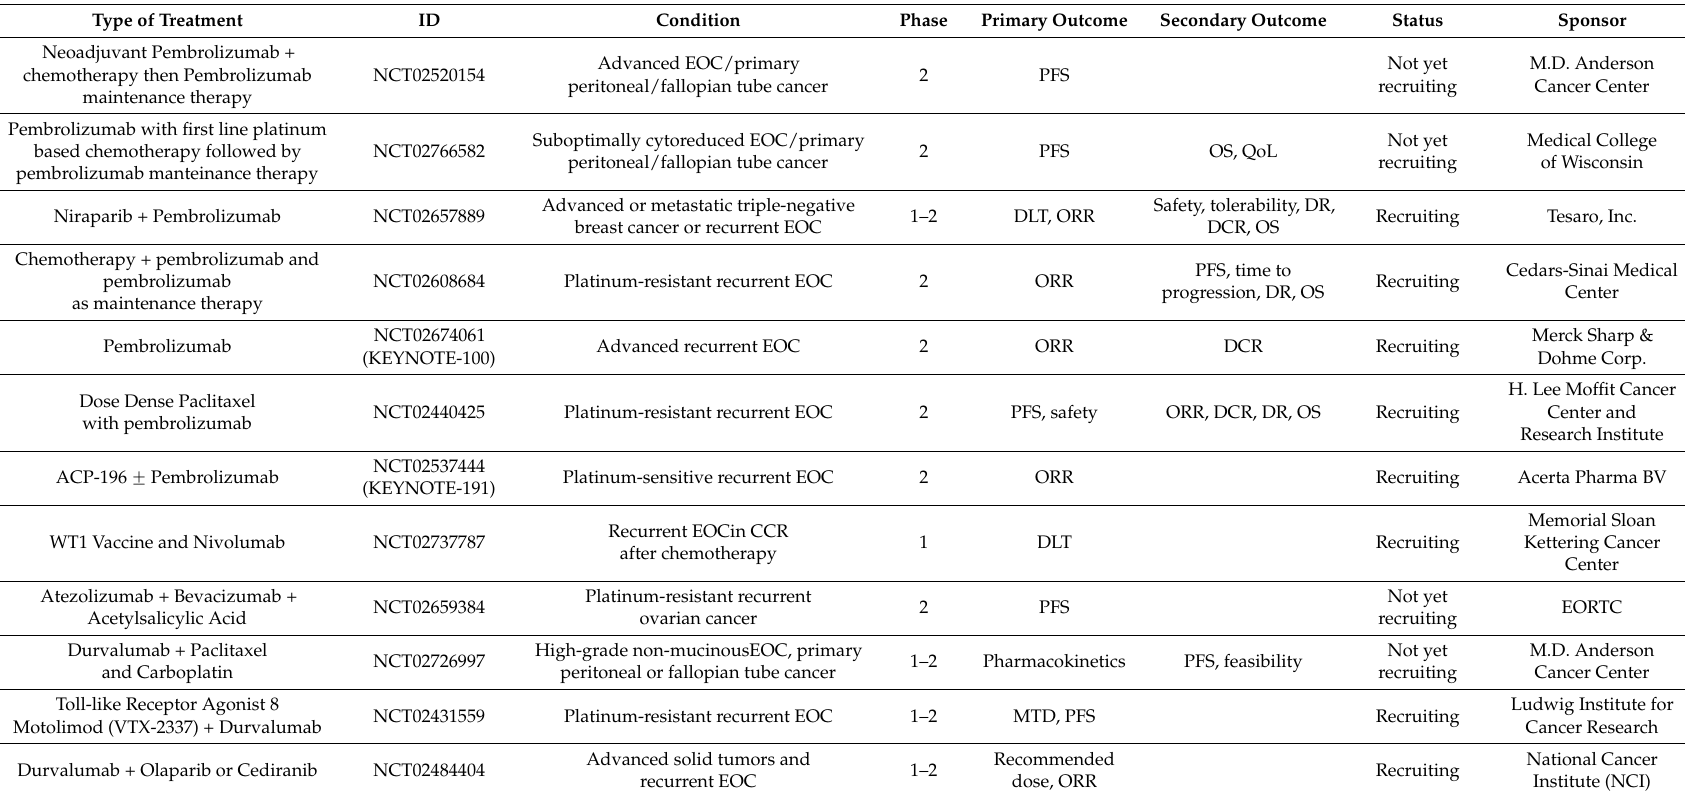
Table 1. Clinical trials with immune checkpoints inhibitors in ovarian